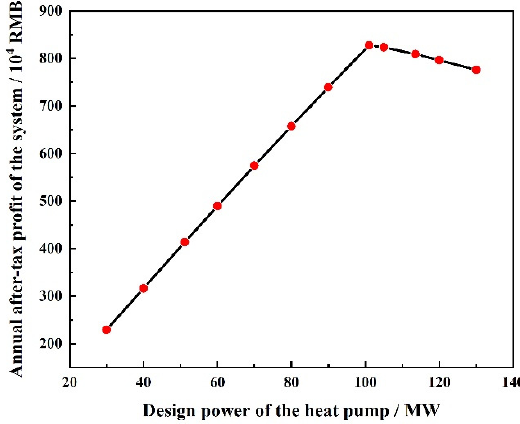
Figure 8. I p at different design powers of the heat pump.